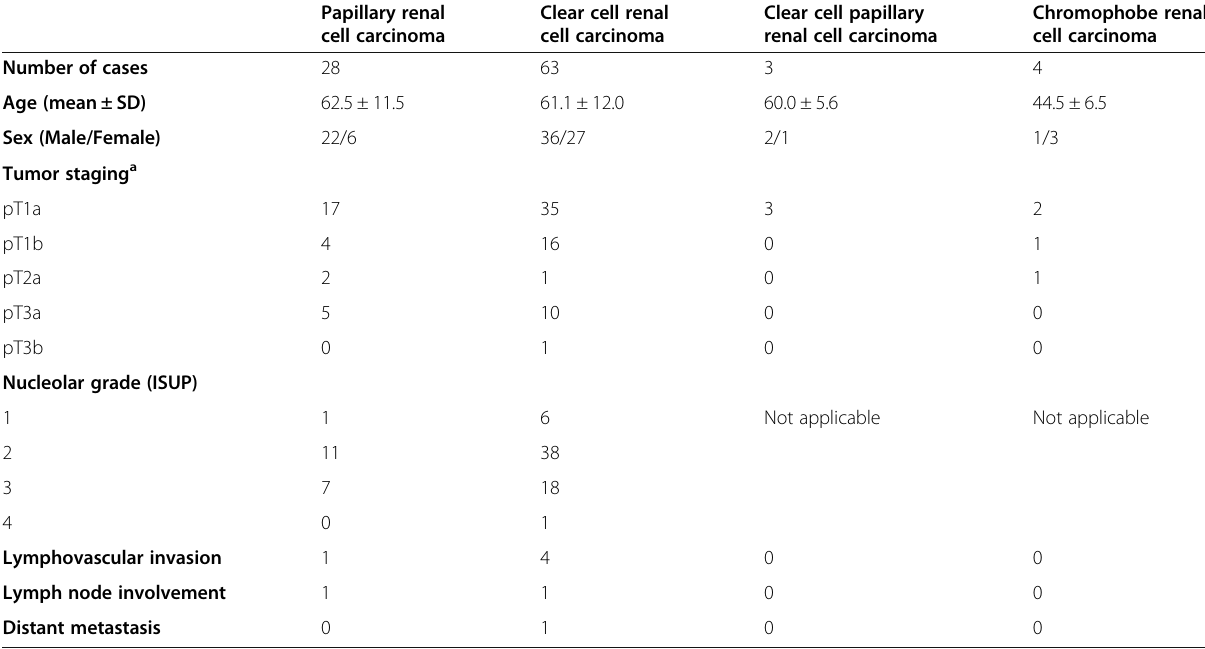
Table 1 Demographics and pathologic features of the 98 renal cell carcinoma cases with prior biopsy